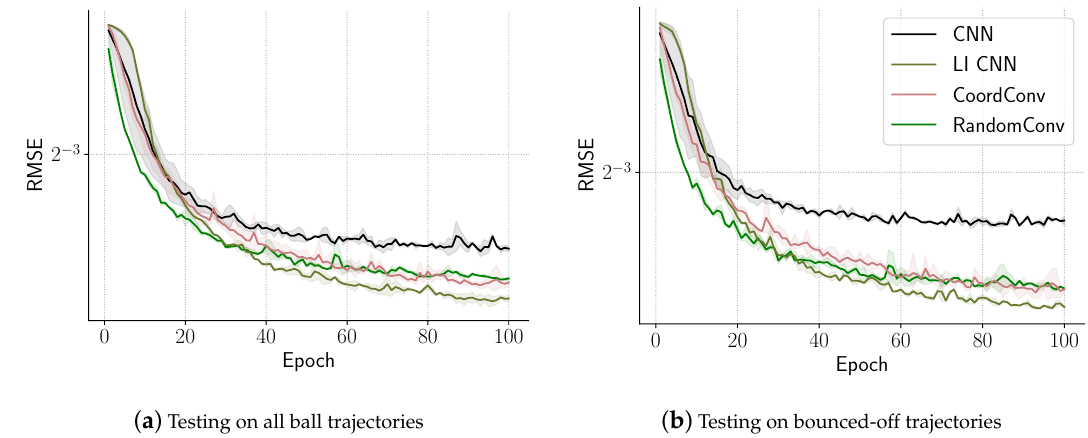
Figure 6. Averaged error on the bouncing ball task vs. epochs of training. Errors are plotted on a logarithmic scale. Shading indicates min/max